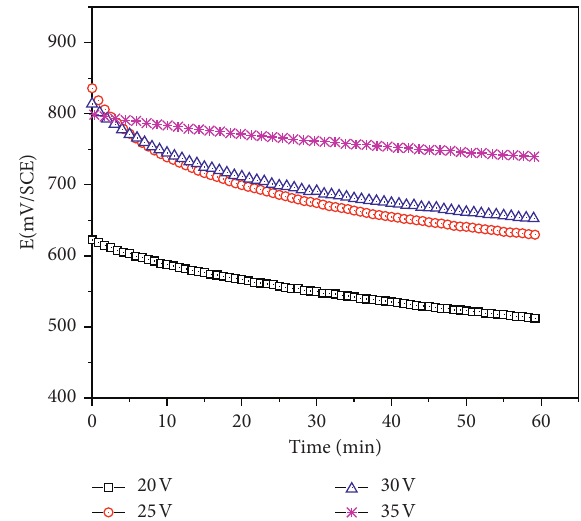
Figure 9: Open-circuit potential against time in 0.1 M Na